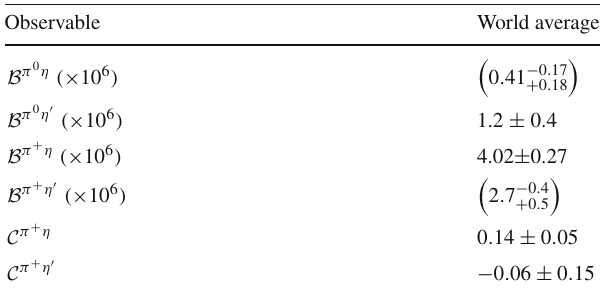
Table 9 World averages for the branching ratios and direct CP asym- metries of the B 0 , + → π 0 , + η ( (cid:5) ) modes [66] Observable World average